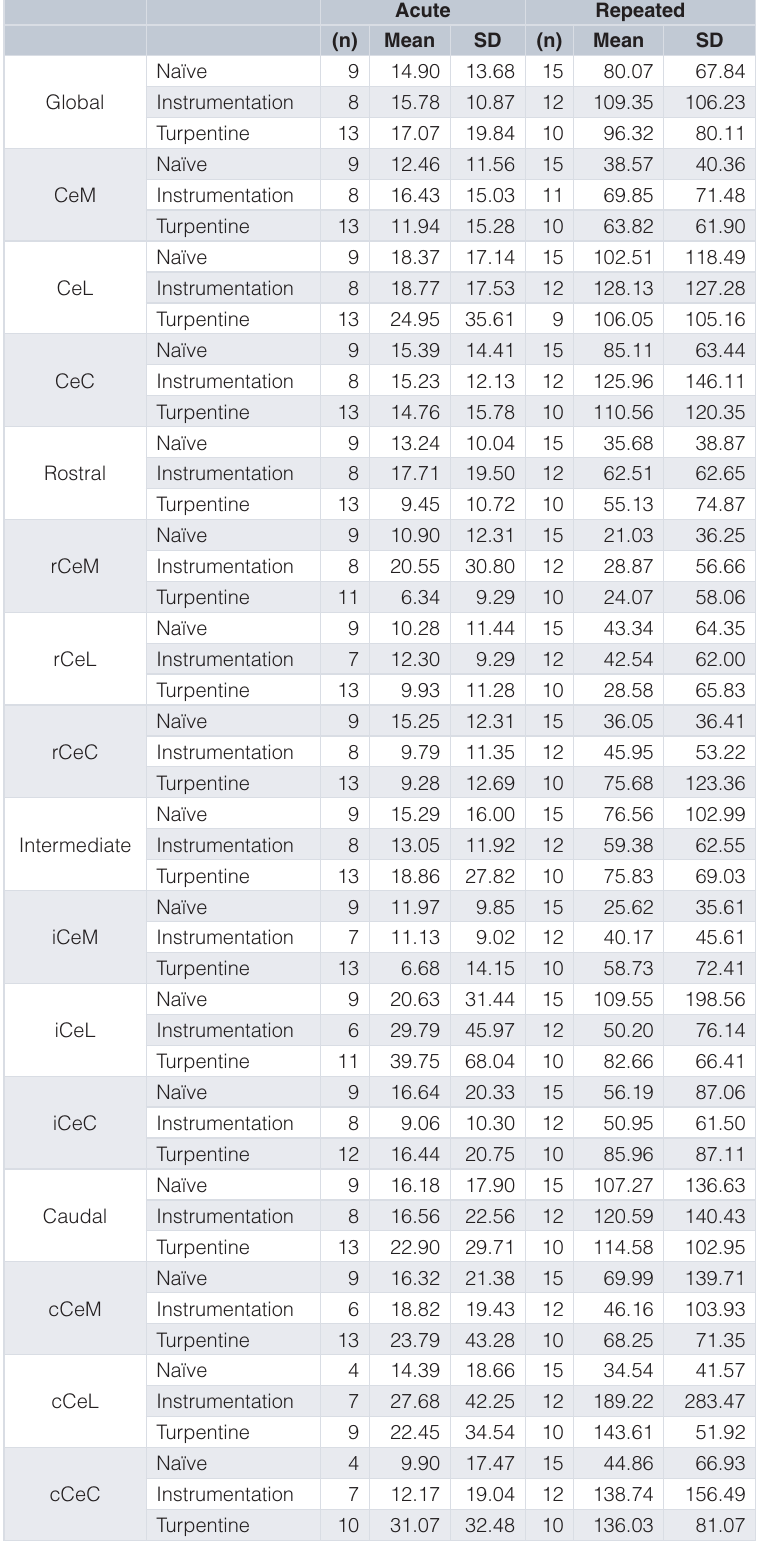
Table 6. c-Fos immunoreactivity in the central amygdala in response to open field exposure 24hrs after bladder inflammation. Data presented as mean (95% confidence interval). Acute: n=8–13; Repeated: n=7–15. Data shown as mean